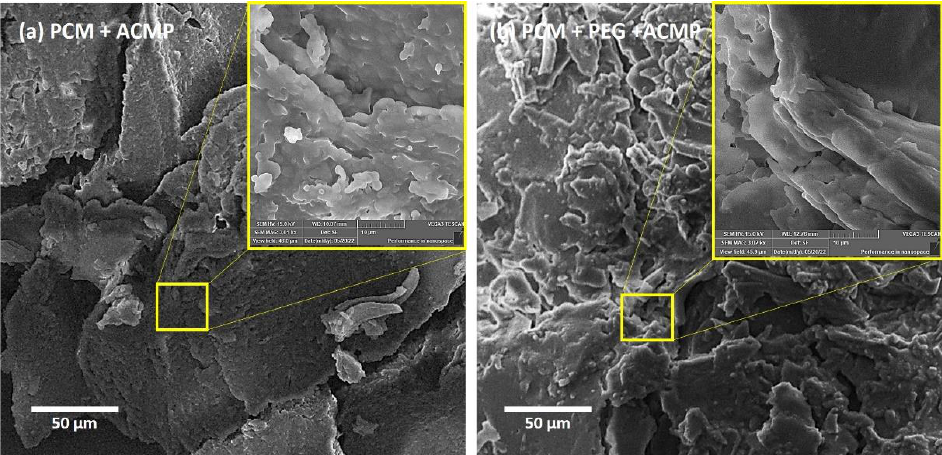
Figure 4. SEM images of phase change material (PCM) samples containing optimum concentration of ( a ) paraffin wax and activated carbon macroparticles (ACMPs) and ( b ) paraffin wax + polyethylene glycol (PEG) + activated carbon macroparticles (ACMPs).